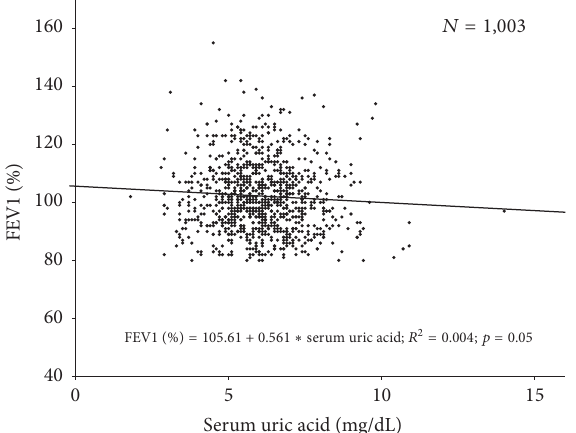
Figure 3: Simple linear regression analysis showing relationships of the FEV1 (%) with serum uric acid.